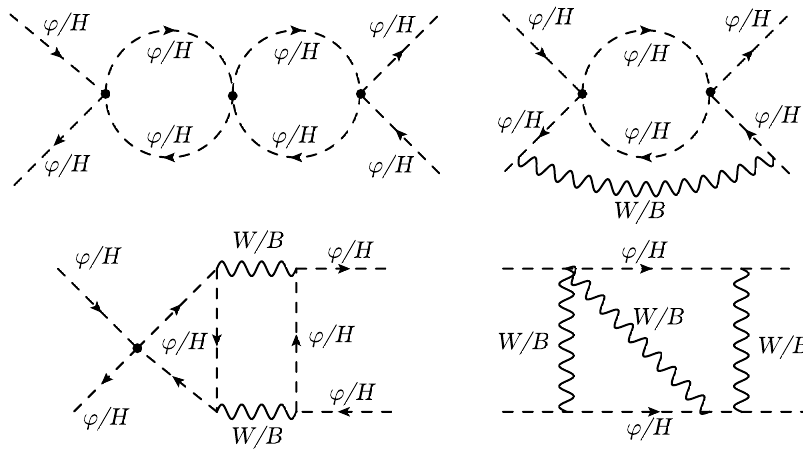
Figure 4. Sample Feynman diagrams which give contributions to quartic scalar couplings (cid:21) H , (cid:21) ’H , (cid:21) 0 , and (cid:21) ( J ) ’ from ’ . These diagrams divide into four classes: zero (top left), one (top ’H right), two (bottom left), and three (bottom right) gauge boson